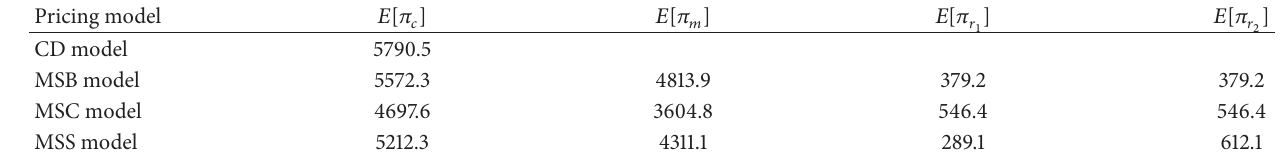
Table 3: Maximum profit of total system and every firm under different pricing models.